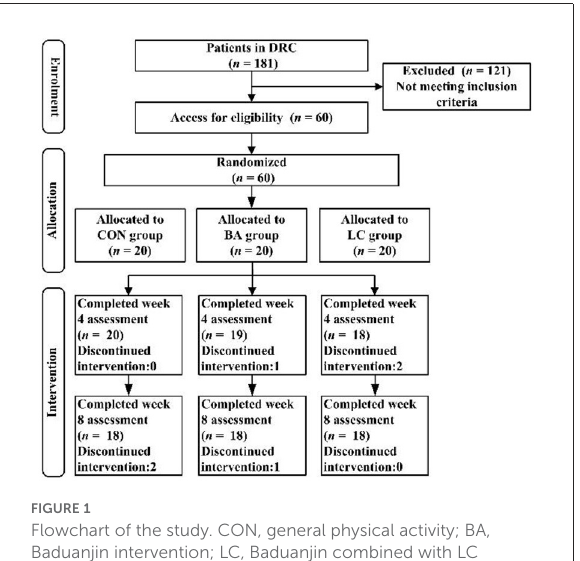
FIGURE1 Flowchart of the study. CON, general physical activity; BA, Baduanjin intervention; LC, Baduanjin combined with LC